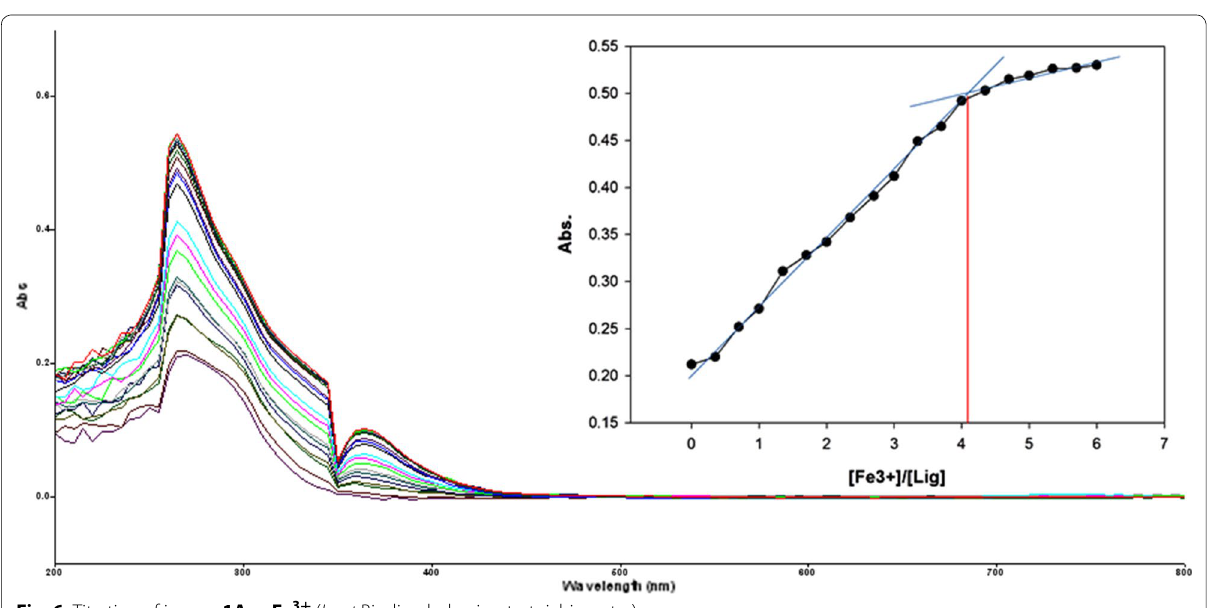
Fig. 6 Titration of isomer 1A vs Fe 3 + ( Inset Binding behavior